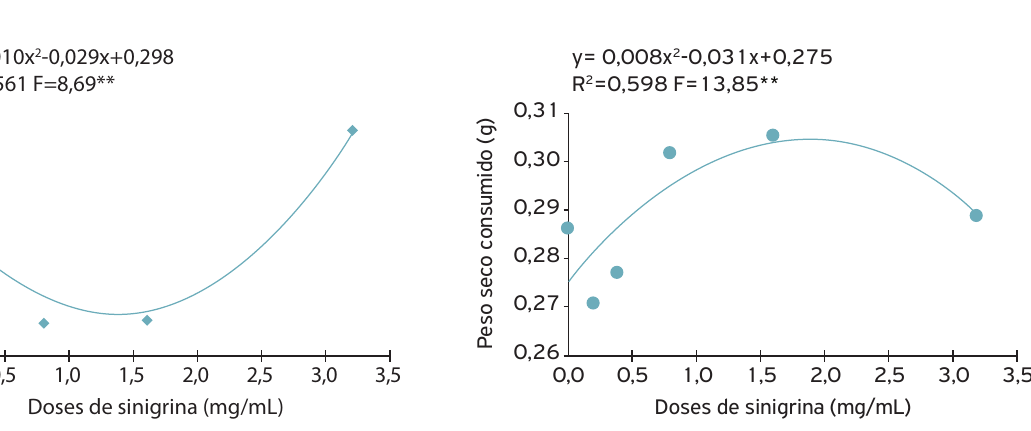
Figura 3. Curva ajustada para regressão polinomial entre o peso fresco consumido de folhas de couve por lagartas de Plutella xylostella e doses de sinigrina.